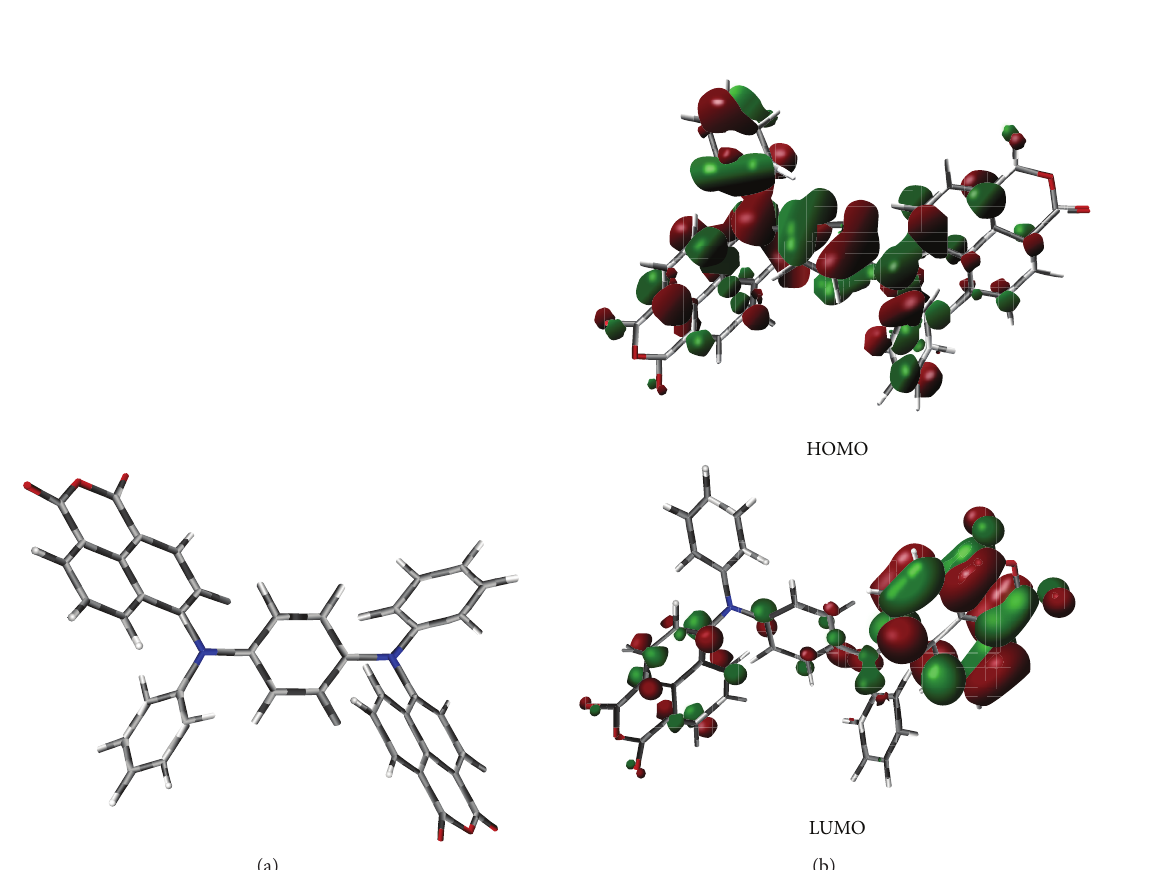
Figure 1: Ground state optimization of EE-1 (a) and HOMO and LUMO frontier orbital of EE-1 (b). done under 100 mW/cm 2 light intensity and AM 1.5 condi- tions. 450 W Xenon light source (Oriel) was used to give an irradiance of various